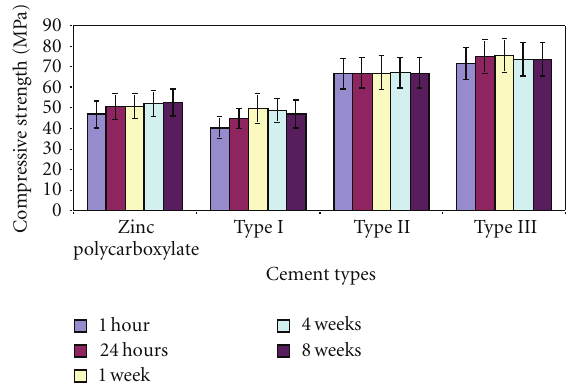
Figure 1: Histogram showing the mean compressive strength of zinc polycarboxylate cement and the three polymeric CPCs in MPa.